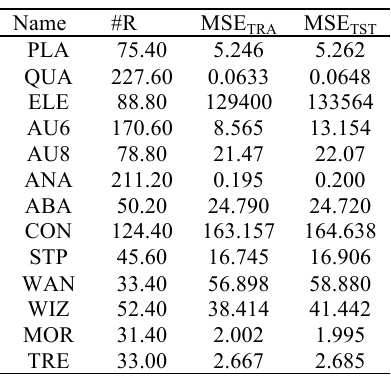
Table 3 Initial Results using the first stage of FS_MOGUL rule